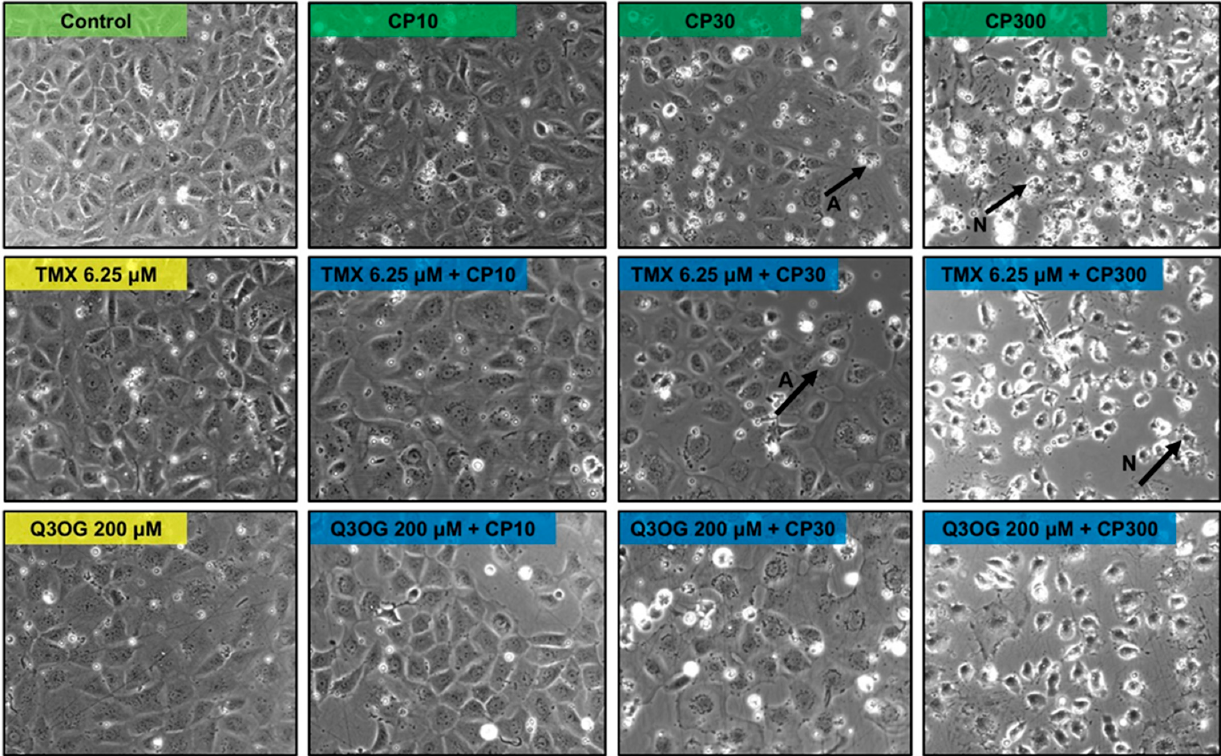
Figure 7. Quercetin, quercetin 3- O -glucuronide and tamarixetin efficacy assays in NRK-52E cells for 24 h against the cytotoxicity of cisplatin. The cells were pretreated for 6 h with the corresponding metabolite and subsequently co-treated for 18 h with the metabolite and 10, 30 and 300 μ M cisplatin, respectively. The MTT technique was used to estimate cell viability. Values are expressed as the mean ± SEM. Significant differences ( p < 0.05): a vs. Control; b vs. Protective treatment alone; c vs. 10 μ M cisplatin; d vs. Cisplatin 10 μ M + Protective treatment; e vs. 30 μ M cisplatin; f vs. Cisplatin 30 μ M + Protective treatment. The dotted line represents the state of the cells before treatment (time